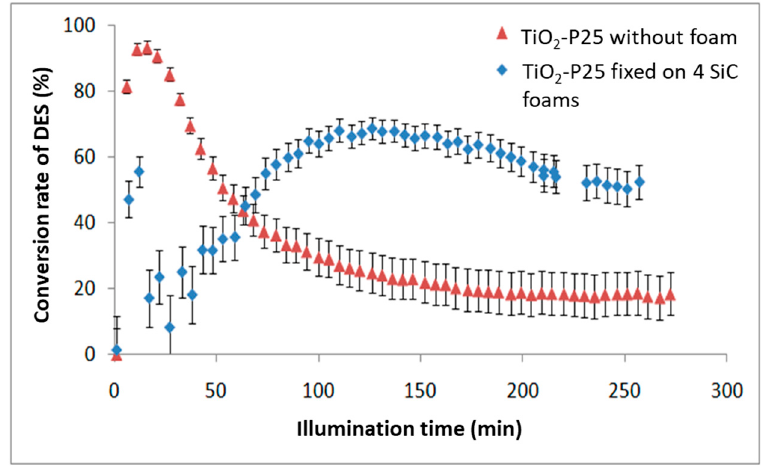
Figure 5. Comparison of DES degradation tests under UV-A illumination with 1 g of TiO 2 P25 supported on β -SiC foams and deposited directly on the walls of the same reactor.